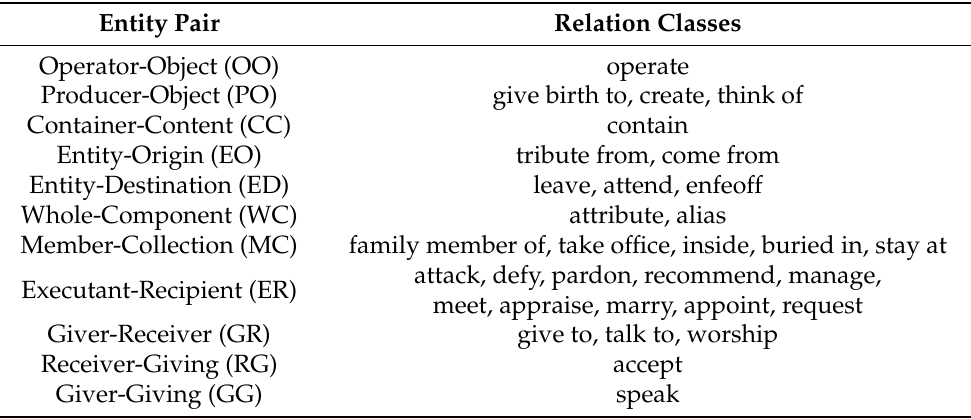
Table 3. All relation classes for TinyACD-RC dataset, where entity type is the category for entities in sentence and relation classes is their corresponding relation